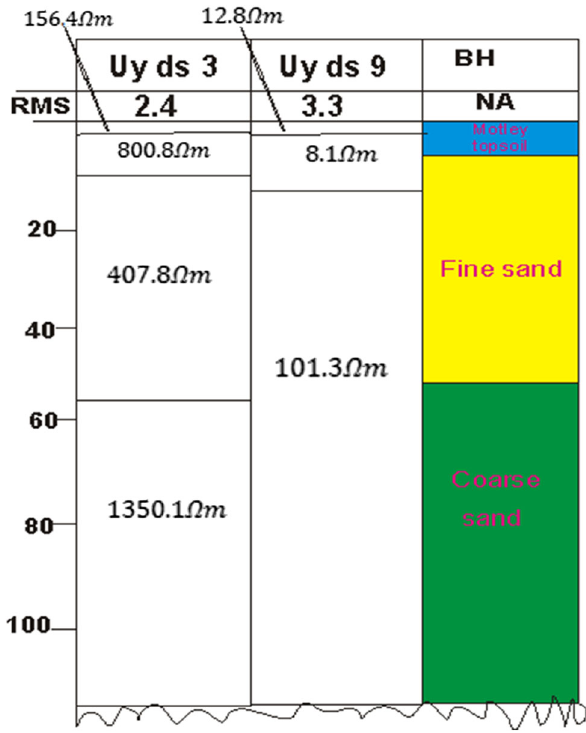
Fig. 2 Borehole lithologic log near VES 3 and VES